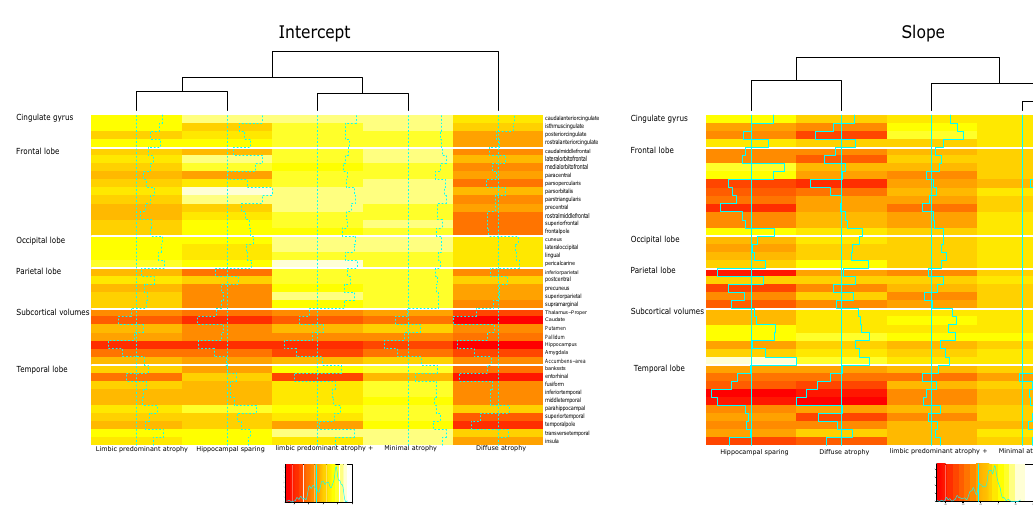
Fig. 3 | Cluster-speci fi c cognitive trajectories after the clinical onset of dementia. The trajectories are estimated with mixed effect models to account for intra subject and cohort variability. MMSE Mini-Mental State Examination, ADAS